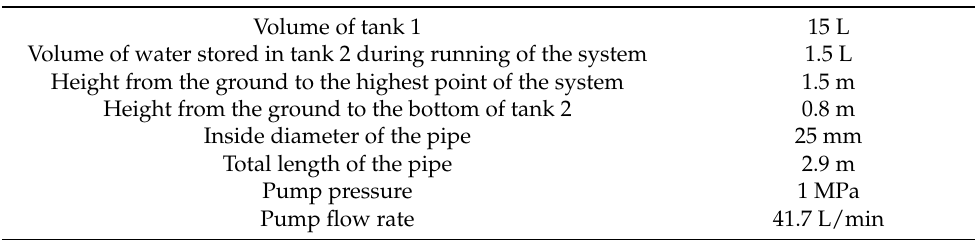
Table 1. Specifications of the system. Volume of tank 1 15 L Volume of water stored in tank 2 during running of the system 1.5 L Height from the ground to the highest point of the system 1.5 m Height from the ground to the bottom of tank 2 0.8 m Inside diameter of the pipe 25 mm Total length of the pipe Pump pressure 1 MPa Pump flow